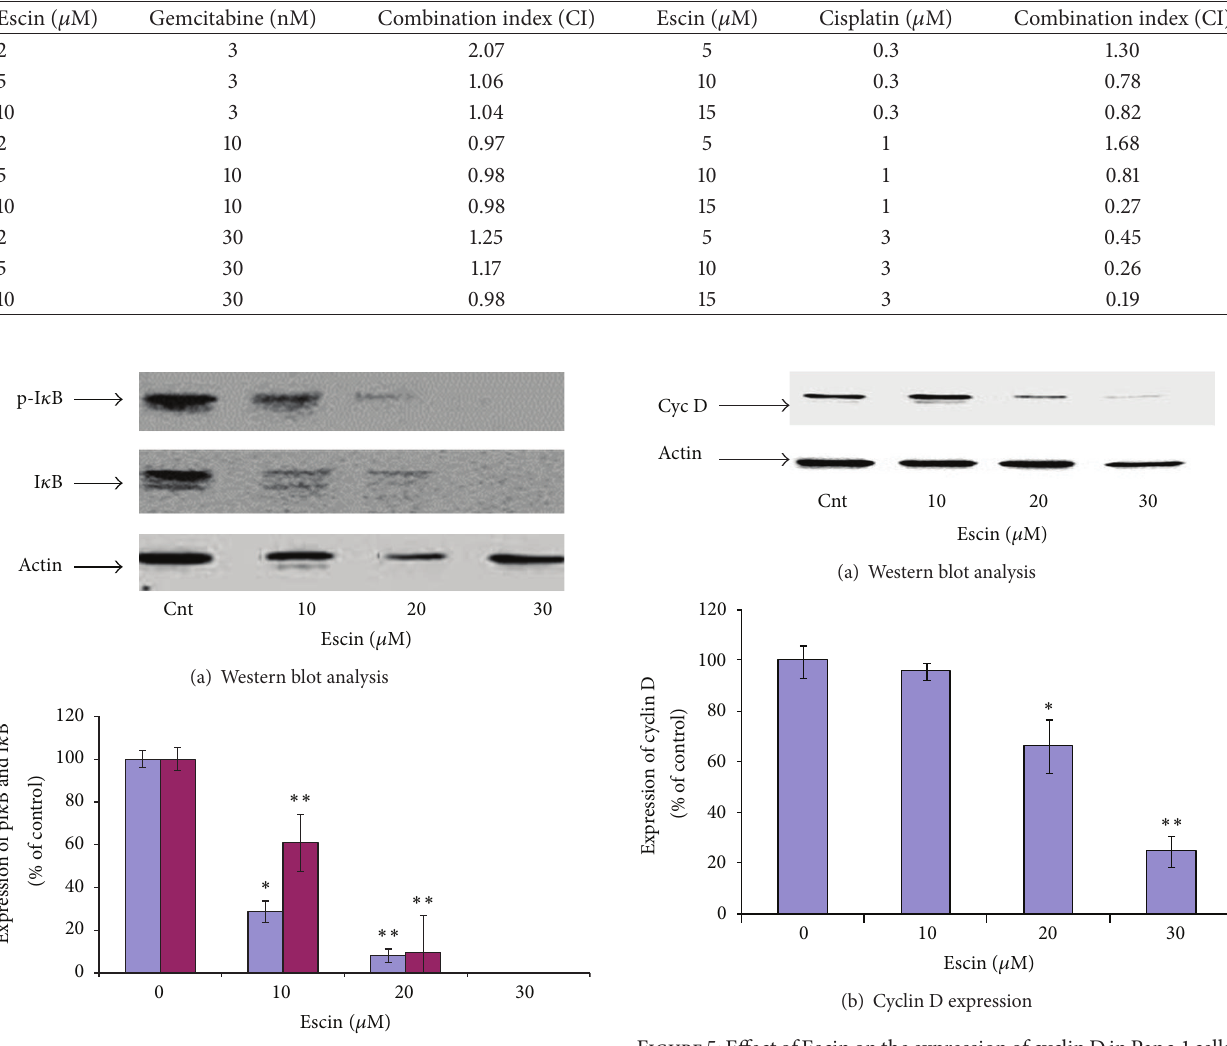
Figure5:EffectofEscinontheexpressionofcyclinDinPanc-1cells. (a) Western blot analysis. (b) Densitometry results averaged from 3 independent